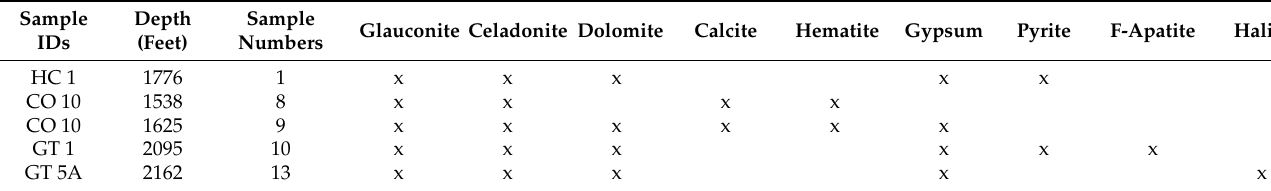
Table 1. XRD data of five of the glauconite-rich pellets studied here.